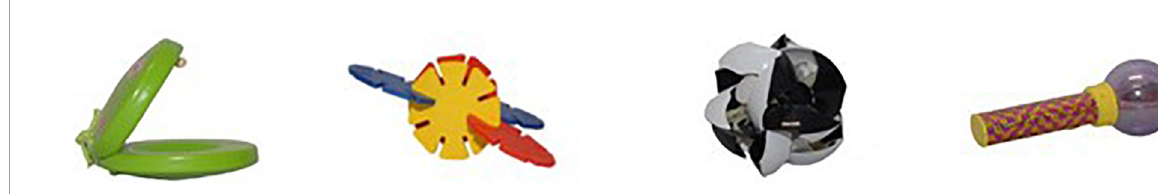
FIGURE1 Target novel objects used in the three word learning paradigms.